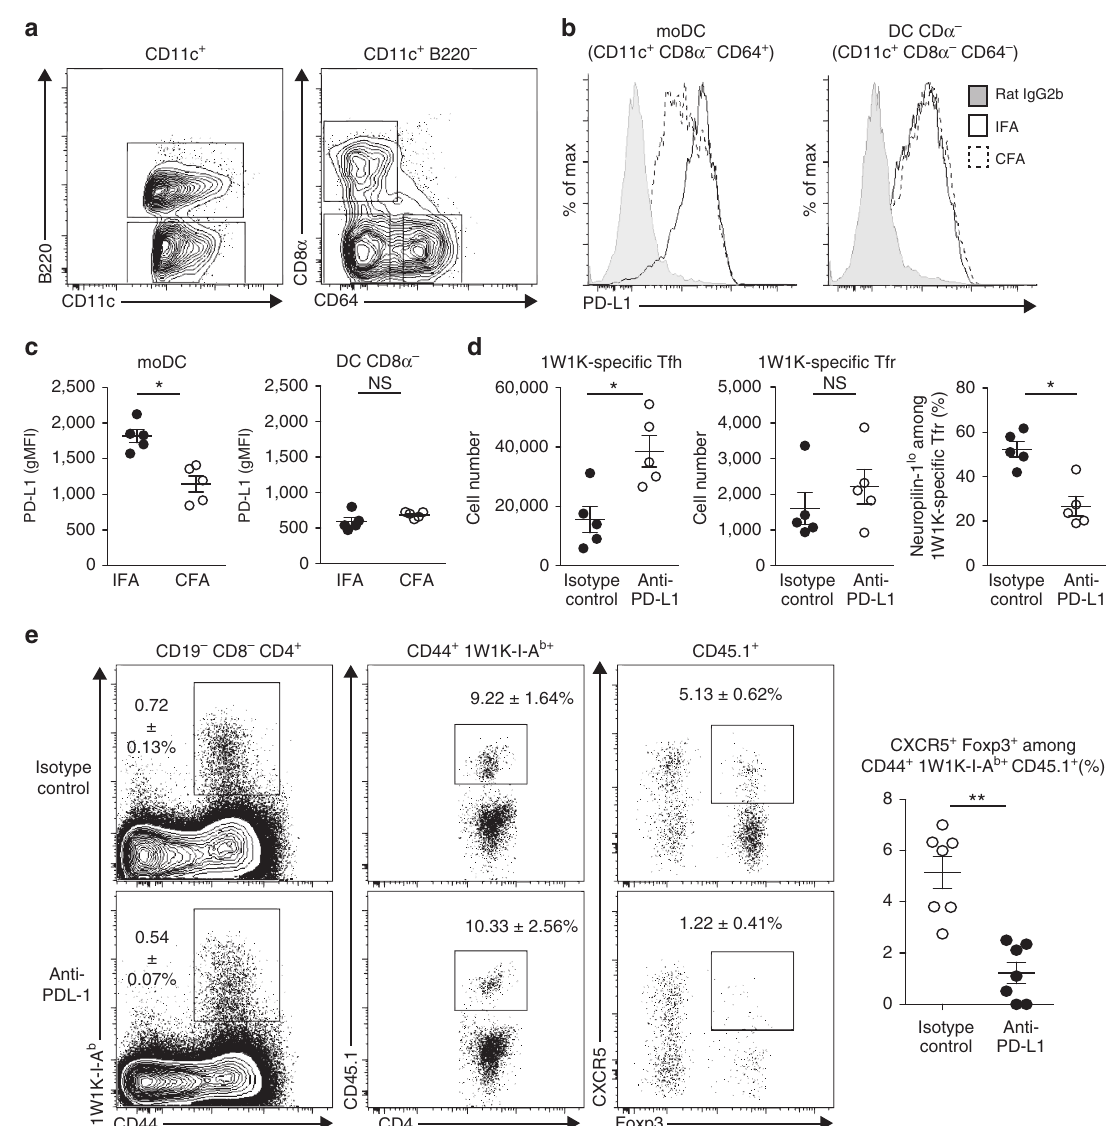
Figure 5 | PD-L1 regulates the formation of induced Tfr cells. ( a ) Flow cytometric contour plots showing DC in the dLN 48h post immunization of WT mice with Ea-OVA in IFA or CFA. ( b ) Histograms showing PD-L1 expression at the surface of conventional CD8 a (cid:2) DC and moDC. ( c ) Geometric mean fluorescence intensity of PD-L1 expression on the surface of conventional CD8 a (cid:2) DC and moDC. Data are from one experiment of five mice per group and are representative of three independent experiments. ( d ) Number of total 1W1K-specific Tfh and Tfr cells in dLN of WTmice 7 days after immunization with 1W1K emulsified in IFA and treated with anti-PD-L1 (white circles) or isotype control (black circles) on days 0 and þ 2. Frequency of Neuropilin-1 lo among 1W1K-specific Tfr cells. Data are from one experiment of five mice per group and are representative of two independent experiments. ( e ) Flow cytometric dot plots showing 1W1K-specific CD4 þ T cells (CD44 þ 1W1K-IA b þ ), transferred cells among 1W1K-specific CD4 þ T cells (CD45.1 þ ) and Tfr cells (CXCR5 þ Foxp3 þ ) in the dLN 7 days post immunization with 1W1K in IFA and treated with anti-PD-L1 (white circles) or isotype control (black circles) on days 0 and þ 2. Data shown are from one experiment with seven mice and are representative of two independent experiments. Data were analysed using the non-parametric Mann–Whitney test. * P o 0.05, mean ±